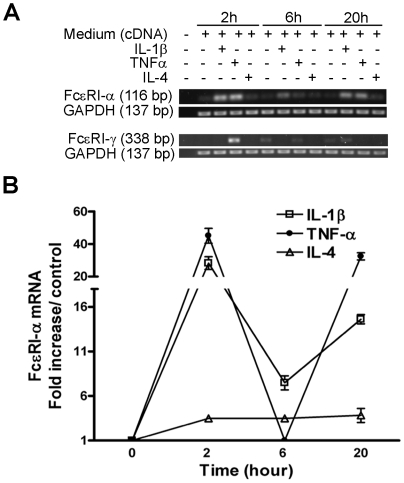
Proinflammatory and Th-2 cytokines upregulate the FcεRI mRNA expression in human B/TSM cells.Human B/TSM FcεRI-α and –γ mRNA expression was analysed by (A) RT-PCR and (B) by Real-time RT-PCR for FcεRI-α chain. GAPDH was used as internal control for (A) and to normalize the FcεRI-α copy number for (B) as described in
Materials and Methods
. Each data point (except for TNF-α at 6 h) represents a significant (p<0.05, n = 3) increase in copy no. over unstimulated control. P values were calculated using Mann Whitney U test.